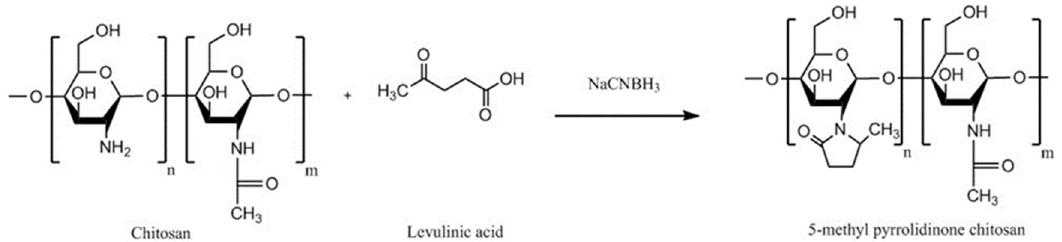
Figure 21. Synthetic pathway to 5-methyl pyrrolidinone chitosan.